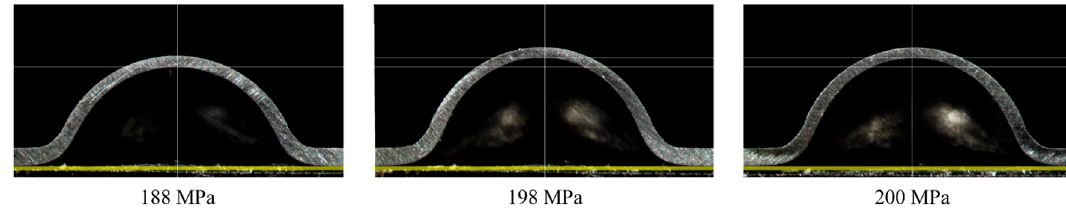
Figure 8. The pressure-displacement curve of Q345R and S30408. Materials 2017 , 10 , 23